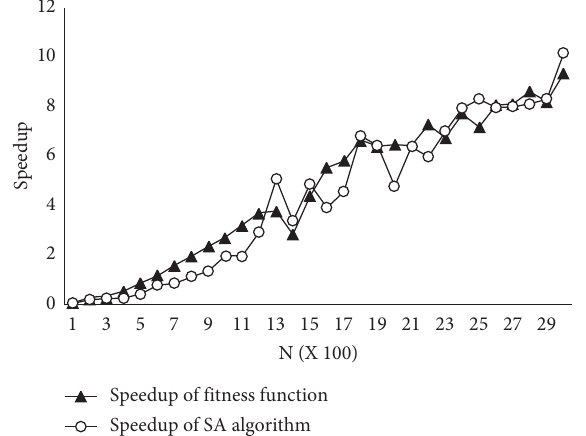
Figure 7: Speedup of the GPU scheme in SA